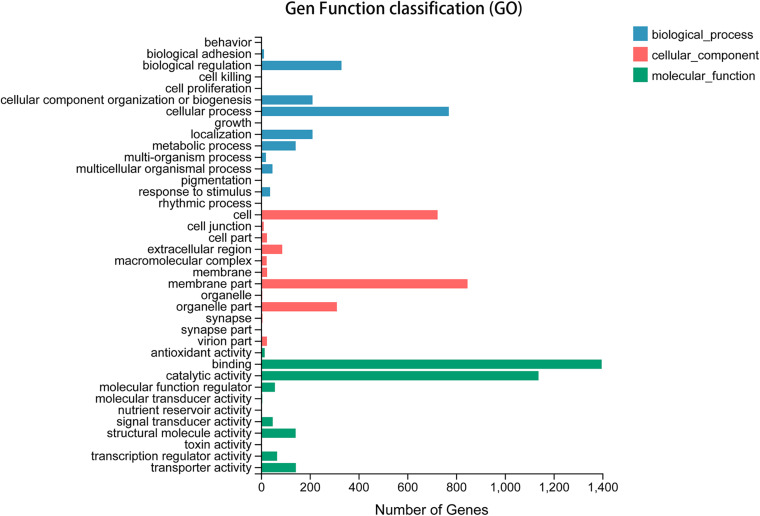
Gene ontology classifications of A. chinensis antennal transcriptome unigenes. The abscissa x-axis denotes the number of genes in the category.